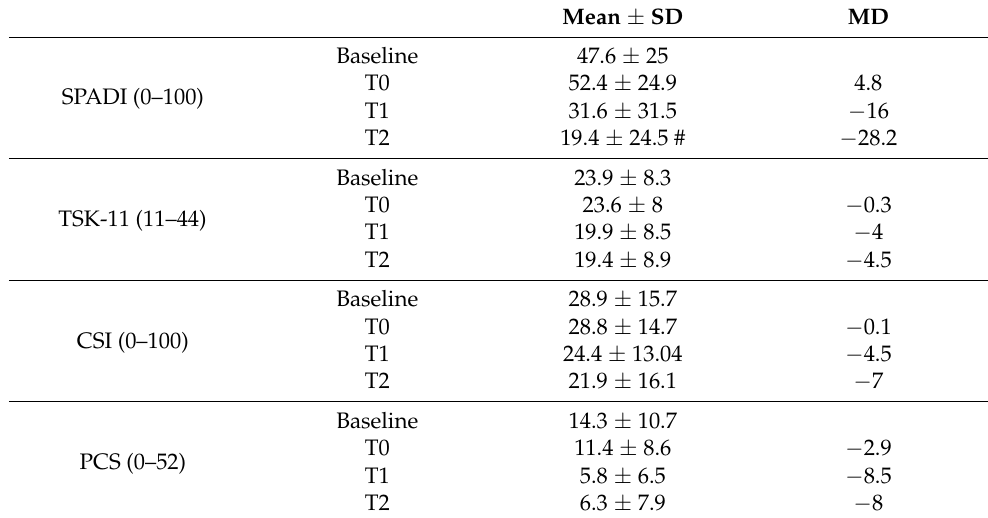
Table 2. Questionnaires results at baseline, two-week “washout” period (T0), post treatment (T1), and follow-up